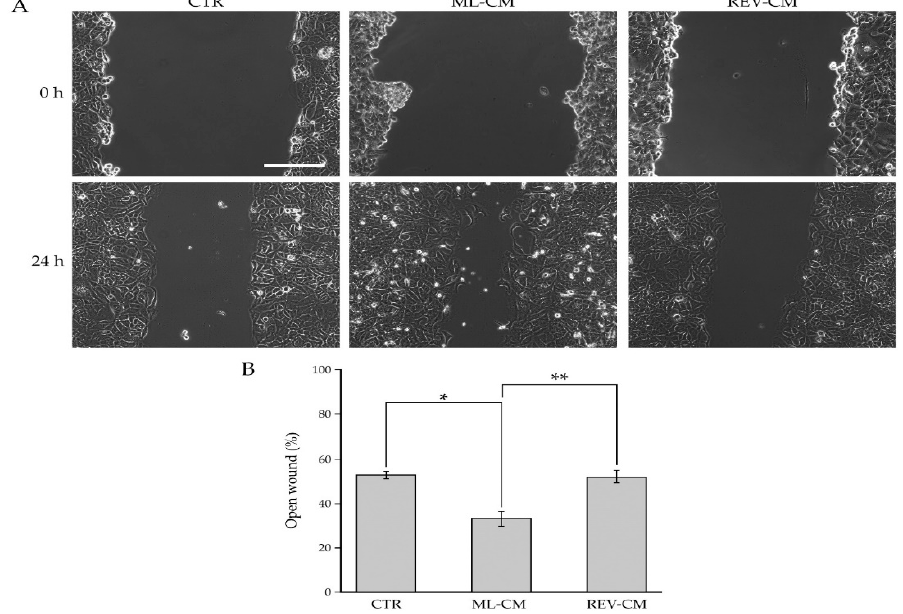
Figure 8. Influence of BCAF monolayers and reverted BCAFs on the migratory capability of BC cells. ( A ) Wound-Healing Assay of MCF-7 cell line grown for 24 h with the conditioned media from BCAF monolayers (ML CM) and reverted BCAFs (REV CM). Standard cell culture medium was used as control. The representative images of three independent experiments show the same fields with scratching at 0 and 24 h after wounding. Scale bar 200 µm. Magnification ×10. ( B ) Migratory capability quantification of MCF-7 cells. Wound widths were measured at 0 and 24 h after wounding. Data are expressed as percentage of fold decrease in open wound area compared with control (0 h) set as 100% and are reported as mean of three independent experiments ± S.E. * p < 0.0005, ** p < 0.0001.